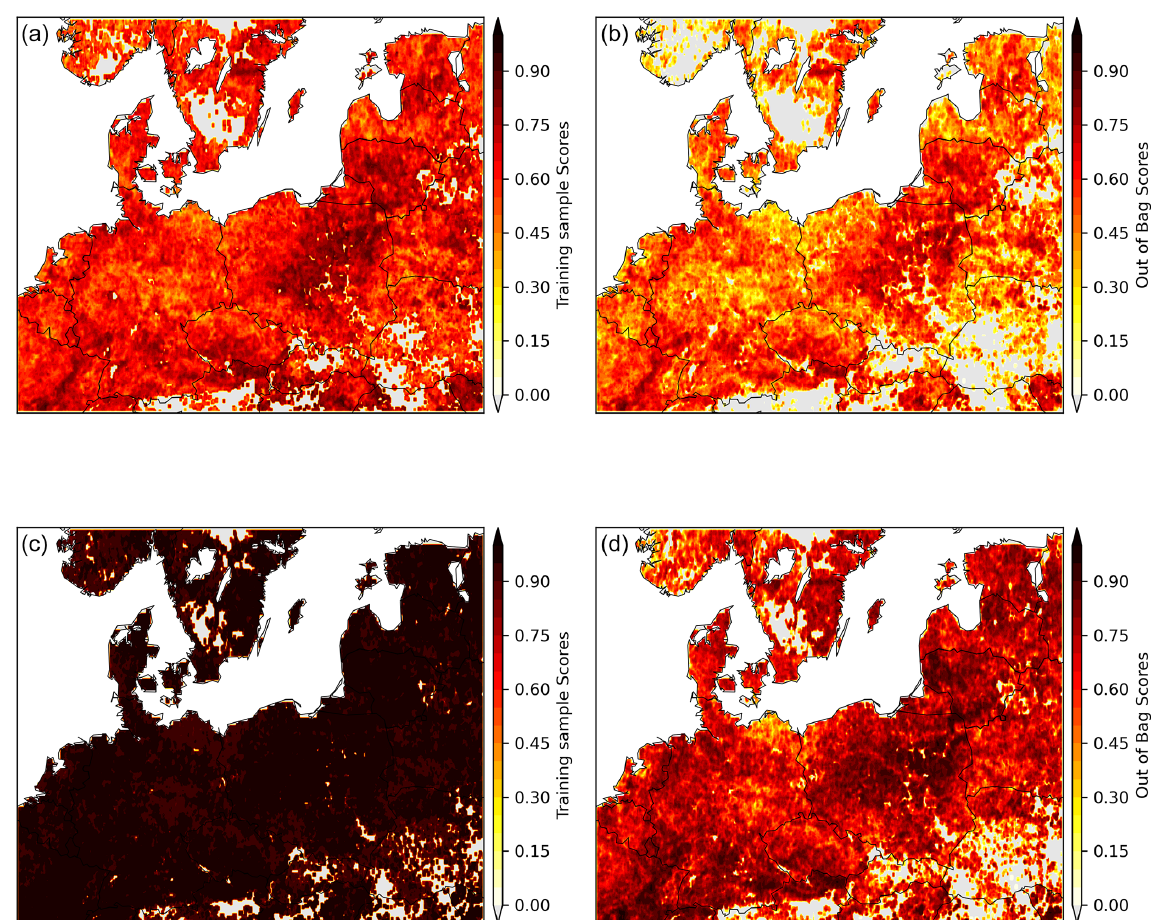
Figure B4. Performance of the temporal RF model in predicting EVI anom given by the out-of-bag scores. Panels (a) and (b) show the scores for the climate-driven RF model, and panels (c) and (d) show the corresponding results for the same model but including EVI yr additional